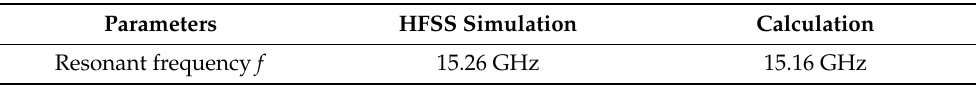
Table 3. Comparison between the resonant frequency of the Mode 1 antenna obtained by HFSS simulation and the calculation results of the coupling model.